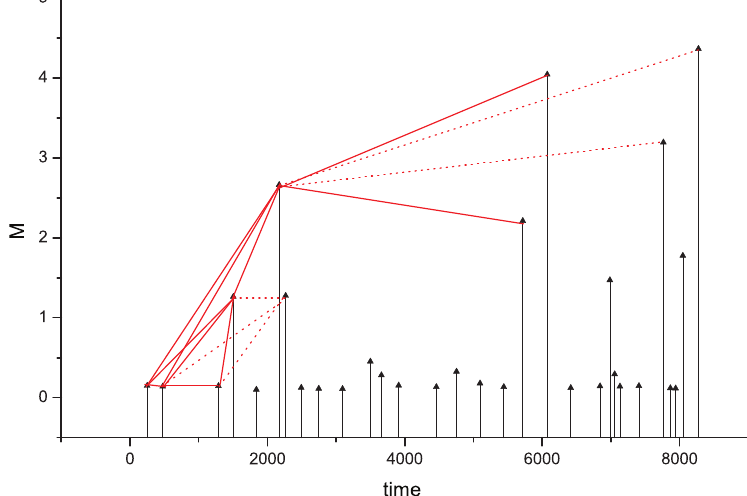
Figure 1. Sketch of the VG method. The black vertical arrows indicate the events; the height of each arrow is proportional to the magnitude. The magnitudes represent the nodes of the graph. The solid visibility rays (red lines) between the events define the permitted links connecting the nodes; the dotted ones define the not permitted links.